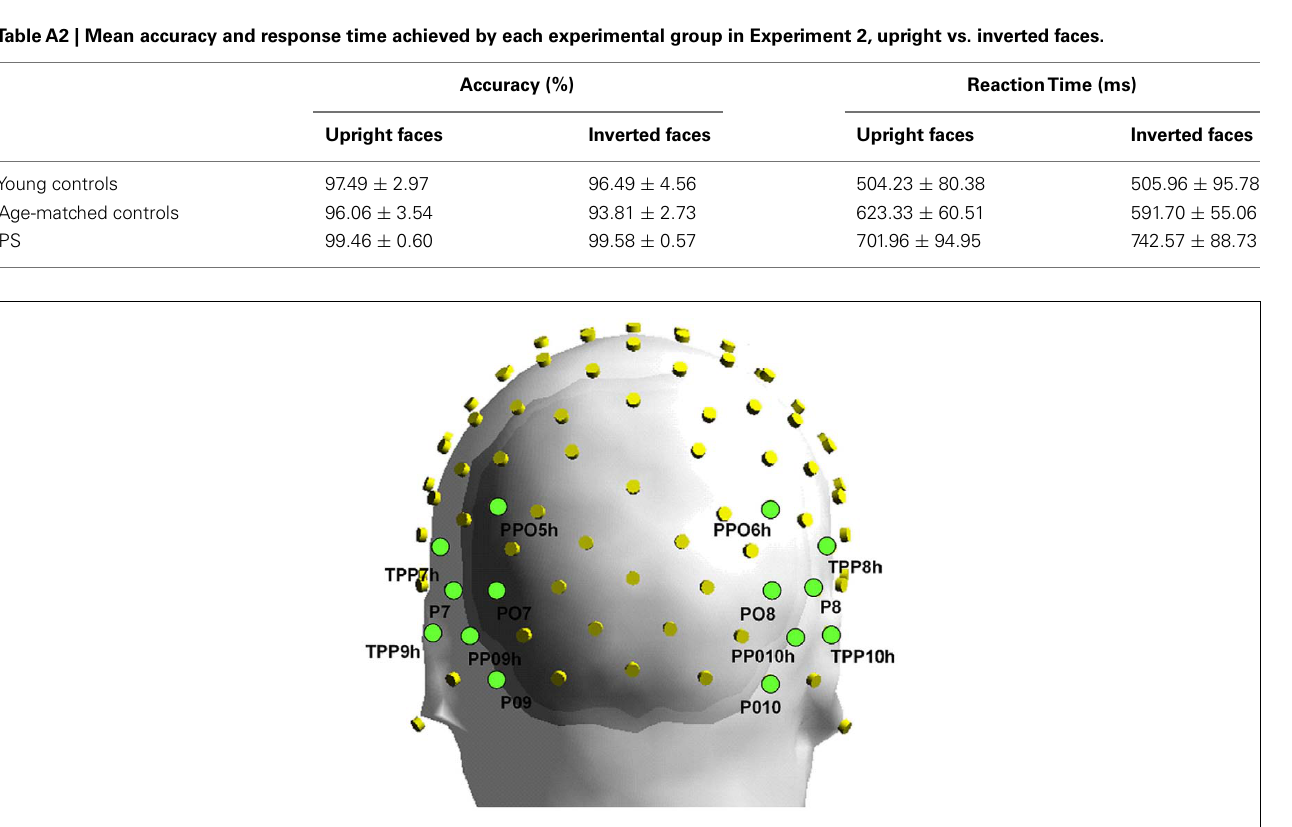
FIGUREA1 | Electrodes layout used for EEG recordings. Back view.The electrodes included in the regions of interest are explicitly indicated.